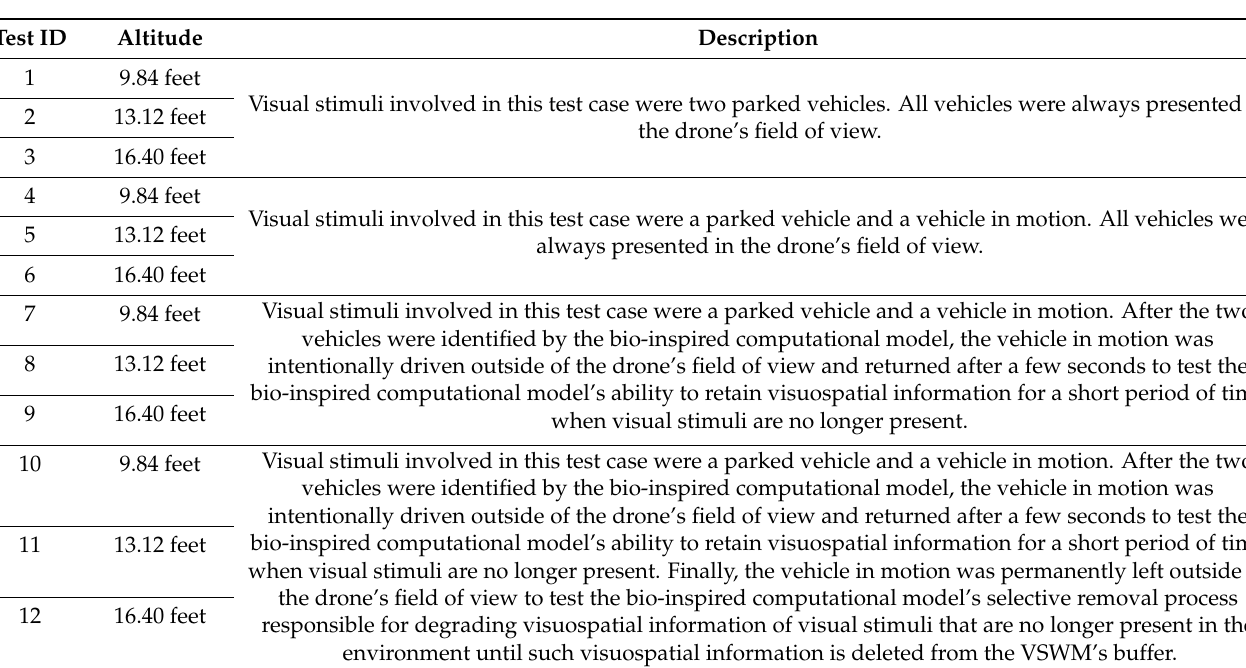
Table 2. Test cases with static and dynamic vehicles.